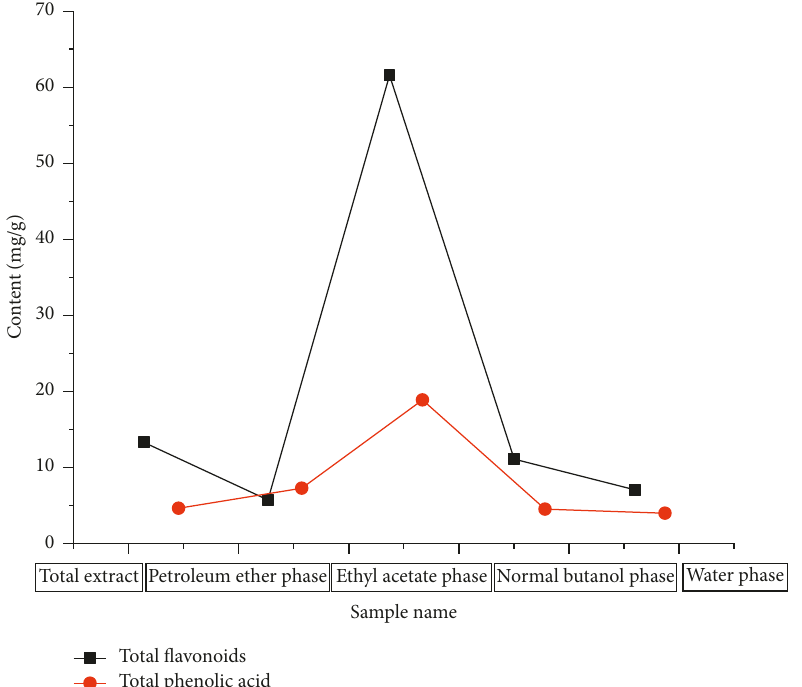
Figure 2: Comparison of total flavonoids and phenolic acid content in different extraction parts of horsetail ethanol